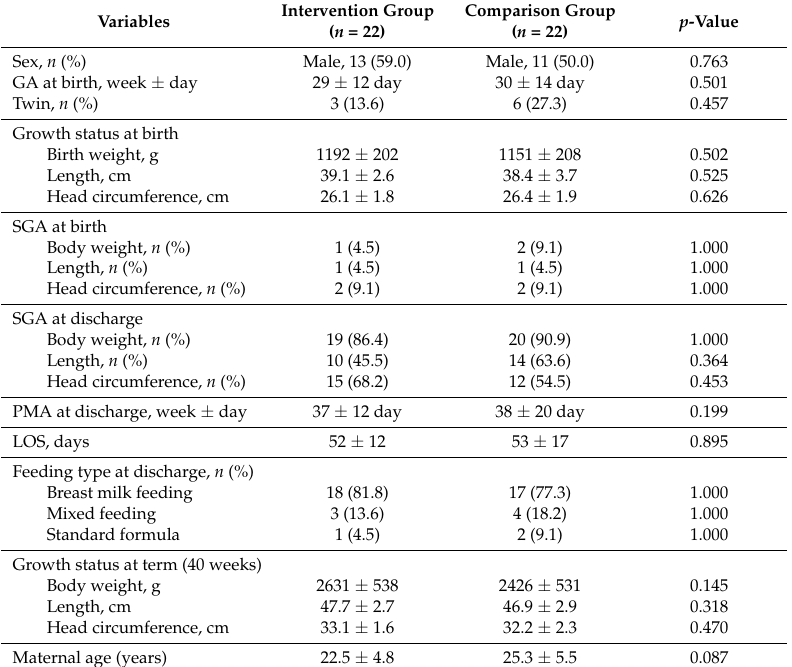
Table 4. Baseline characteristics of the intervention and comparison